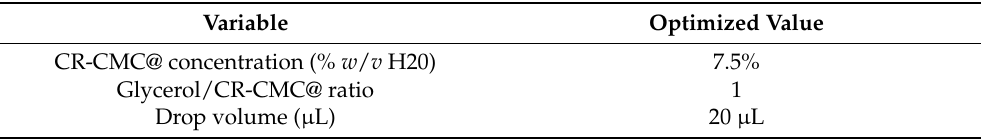
Table 6. Optimized conditions for CR-CMC@ sensors preparation by drop-casting deposition on pure cellulose.